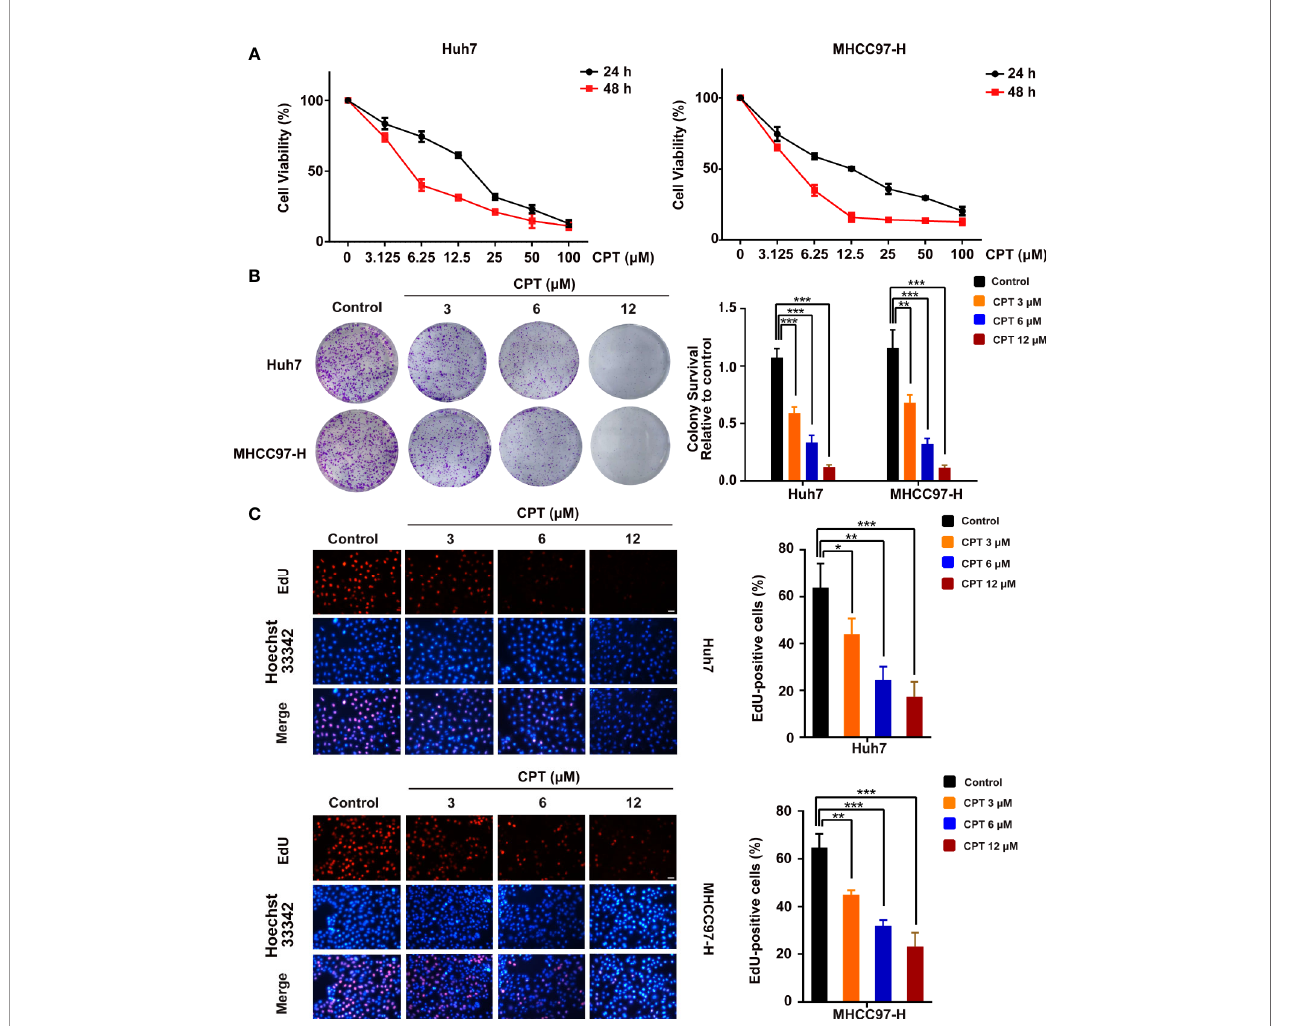
FIGURE 6 | Cryptotanshinone (CPT) inhibits the proliferation of Huh7 and MHCC97-H cells. (A) 3-(4,5-dimethylthiazol-2-yl)-2,5-diphenyltetrazolium bromide (MTT) analysis of human hepatocellular carcinoma (HCC) cell lines, including Huh7 and MHCC97-H cells, treated with the indicated doses of CPT for 24 and 48 h. These experiments were independently repeated three times. (B) A colony formation assay was performed for Huh7 and MHCC97-H cells incubated with various doses (0, 3, 6, and 12 m M) of CPT. Colony survival relative to control groups was calculated and presented as mean ± standard deviation (SD) (n = 3). (C) Proliferative capacity was measured by EdU assay in Huh7 and MHCC97-H cells treated with the indicated concentrations of CPT (0, 3, 6, and 12 m M) for 24 h. * P < 0.05, ** P < 0.01, and *** P < 0.001 versus the control